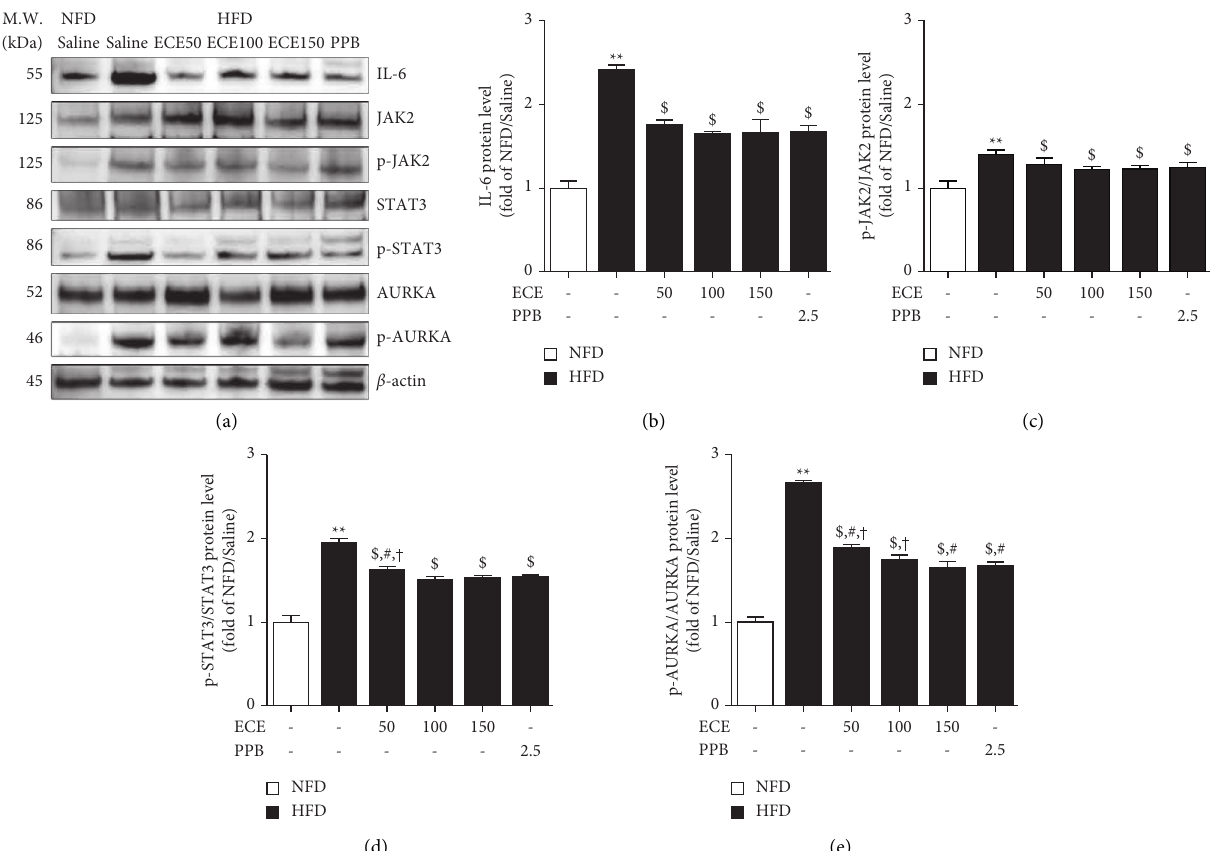
Figure 2: ECE and PPB restore upregulation of IL-6/JAK2/STAT3/AURKA in visceral adipose tissue of HFD animals. (a) The protein levels of IL-6/JAK2/STAT3/AURKA in visceral adipose tissue of HFD mice were assessed by Western blot. (b–e) Quantitative graphs of representative Western blot images. The protein levels were normalized to β -actin. Increased protein levels were restored by ECE and PPB administration. All data are shown as mean ± S.D. ∗∗ , p < 0 . 01, vs. NFD/saline; $ p < 0 . 05, vs. HFD/saline; # p < 0 . 05, vs. HFD/ECE100; † p < 0 . 01, vs. HFD/PPB (Mann–Whitney U test). AURKA, aurora kinase A; ECE, Ecklonia cava extract; IL-6, interleukin 6; JAK2, janus kinase 2; HFD, high-fat diet; NFD, normal fat diet; p-AURKA, phosphorylated AURKA; p-JAK2, phosphorylated JAK2; p-STAT3, phosphorylated signal transducer and transcription 3; PPB, pyrogallol-phloroglucinol-6, 6-bieckol; STAT3, signal transducer and tran- scription